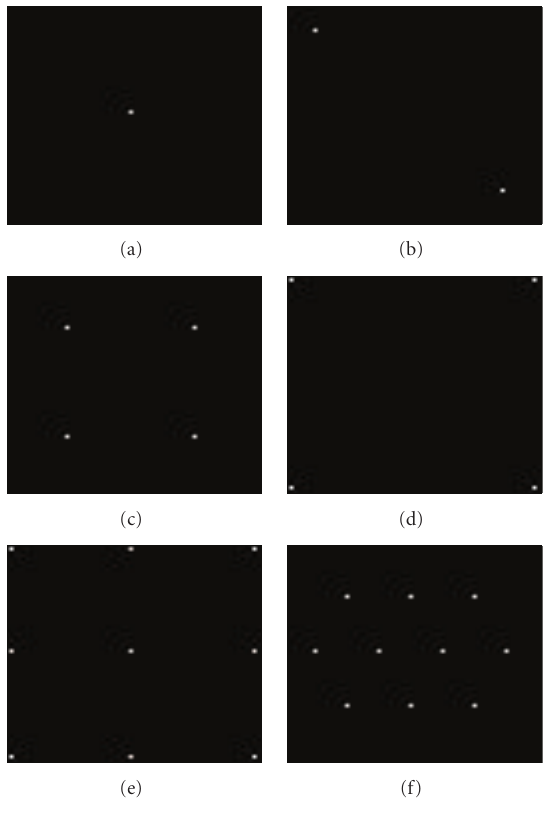
Figure 3: Apertures used in final simulation.